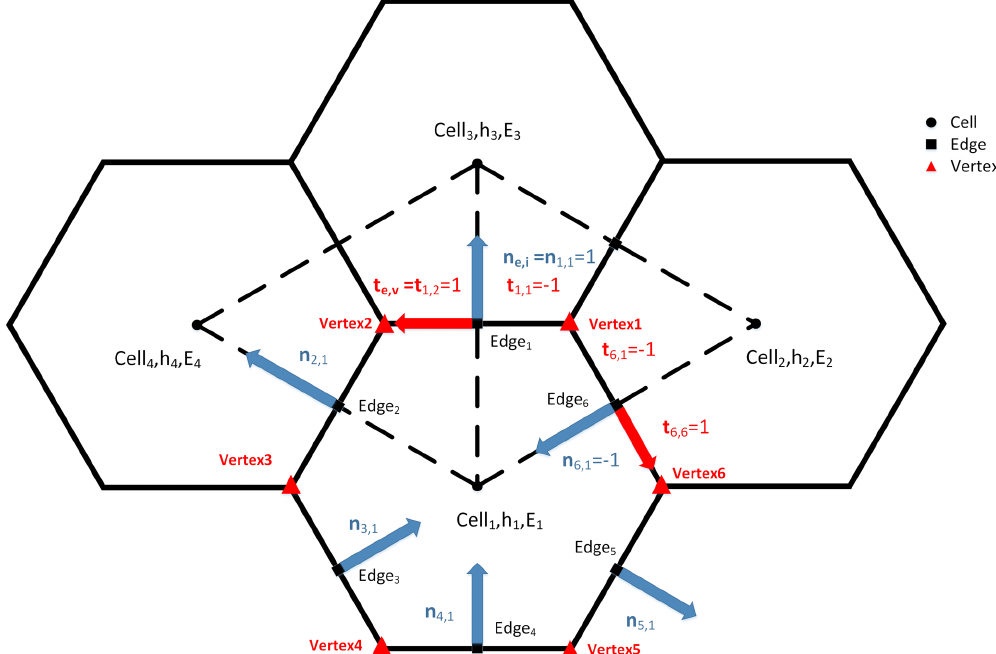
Figure 1. Definition of elements in a discrete system. Blue arrows represent the indicator function n e,i and red arrows are the indicator function t e,v . The uniform grid is here for clearly introducing SCVT meshes, the situation on non-uniform grid is